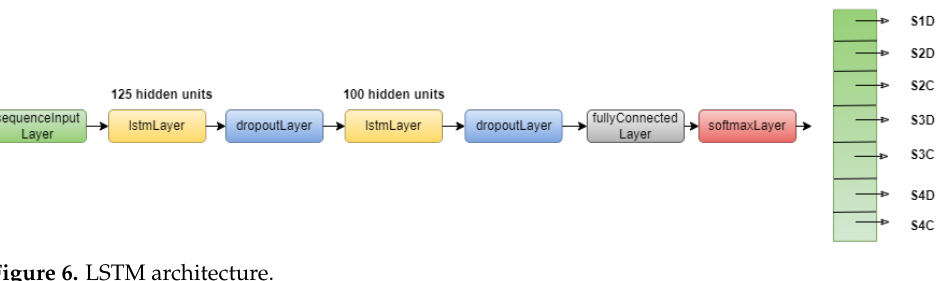
Figure 6. LSTM architecture.